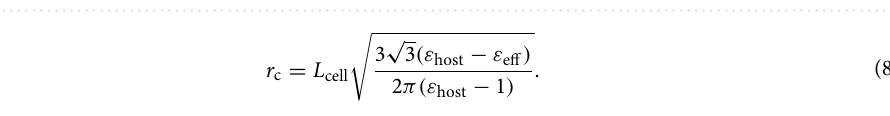
Figure 7. The ray-tracing results for 73 equally-spaced rays launched from the physical space’s inner rim. The results are shown for the transformation medium depicted in ( a ) Fig. 3b, ( b ) Fig. 3c, and ( c ) Fig. 3d. The color expression indicates the optical path